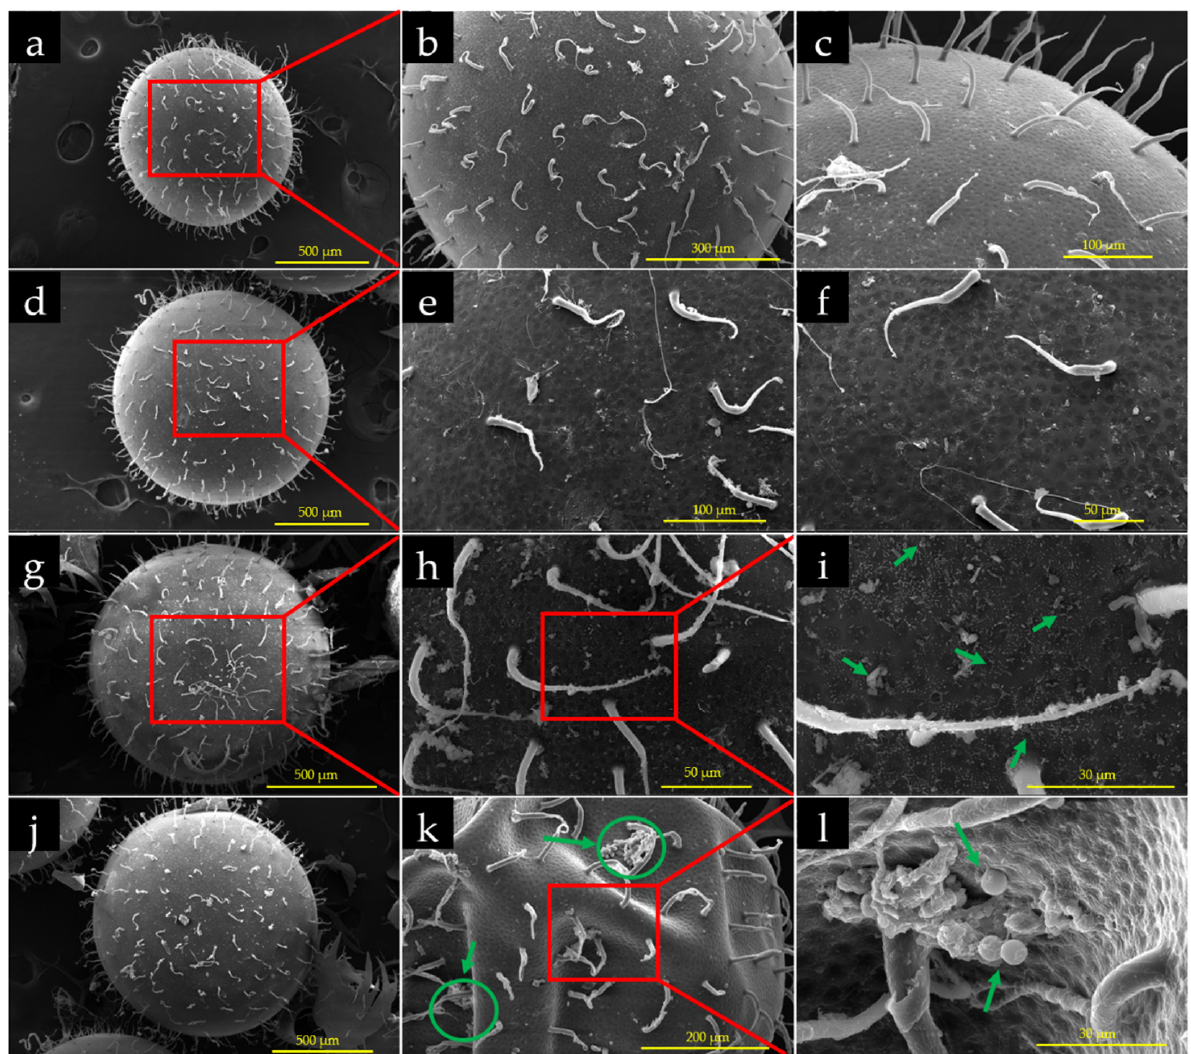
Figure 2. SEM images of O. melastigma embryos exposed to PS-MPs of different sizes for 6 d (n = 9). ( a – c ) control without PS-MPs; ( d – f ) 0.05 μ m; ( g – i ) 0.5 μ m; and ( j – l ) 6.0 μ m. The PS-MPs discovered on the villi or membranes of the embryos are indicated by green arrows, whereas the PS-MPs that occurred as clumps on the embryo surface are indicated by green circles.